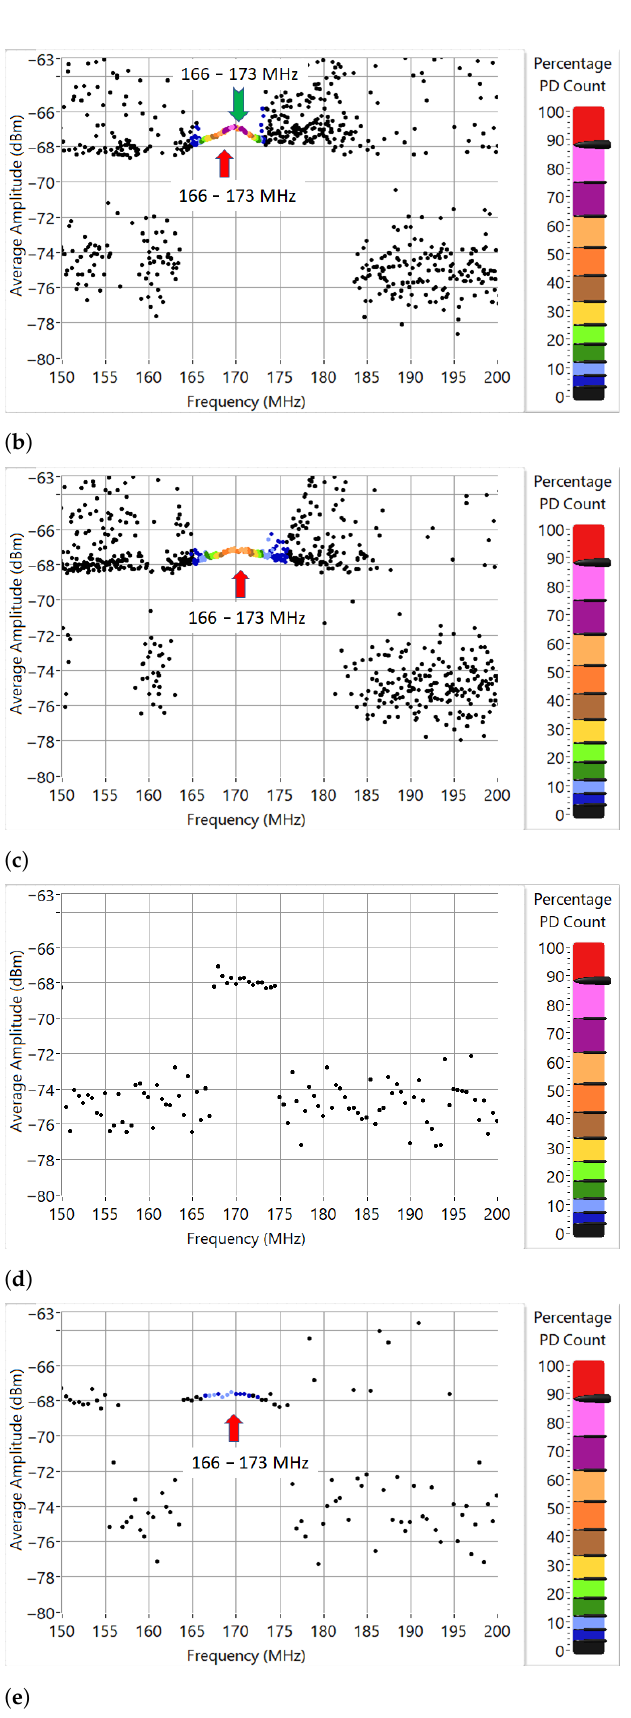
Figure 18. FRPD for different cases, from 150 to 200 MHz: ( a ) corona, ( b ) slot, ( c ) corona with slot, ( d ) noise with the power supply not energized, and ( e ) noise with energized power